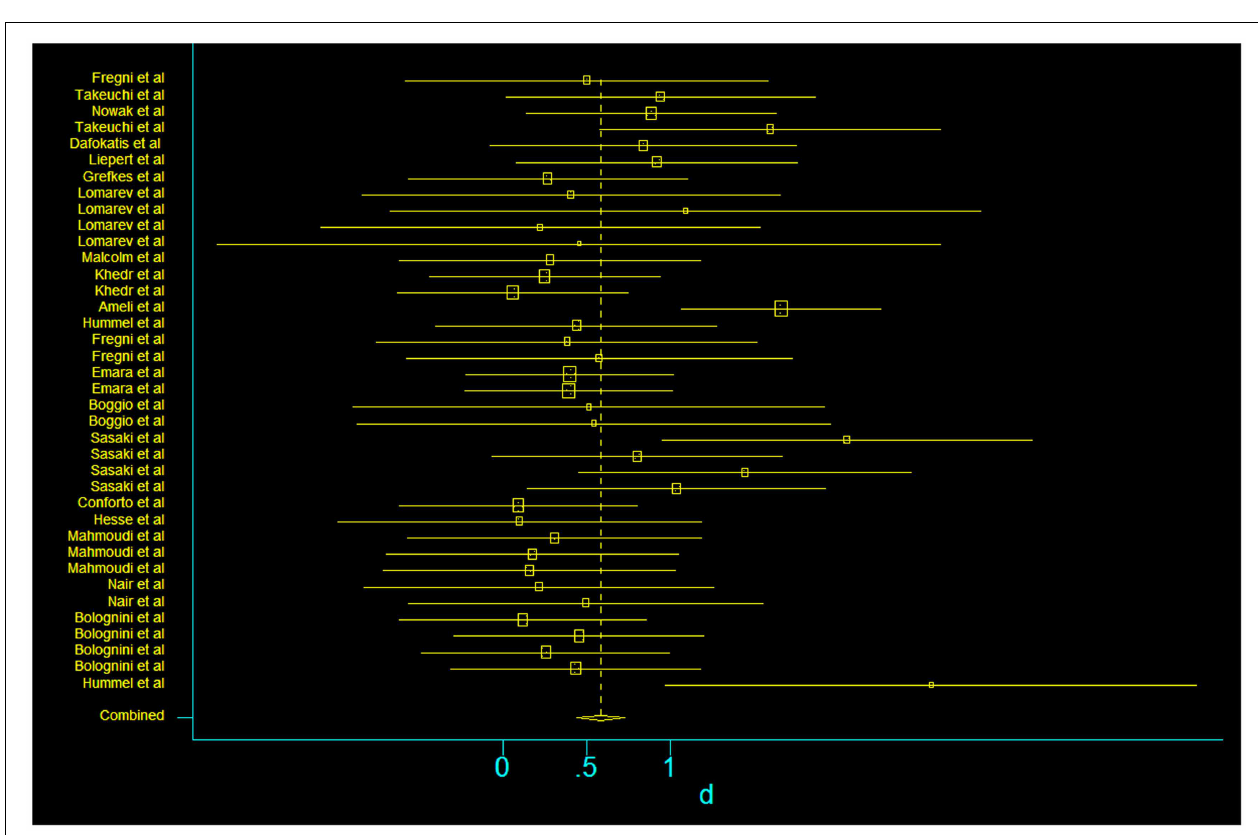
FIGURE 1 | Forest plot of the subset of studies with amenable and data-available for systematized comparison, with the pooled effect size for studies of transcranial stimulation on